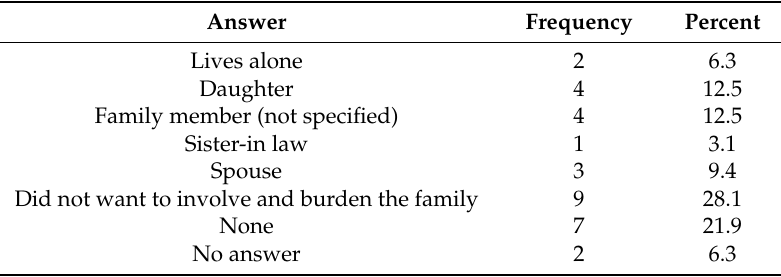
Table 4. Overview of informal care givers involved in